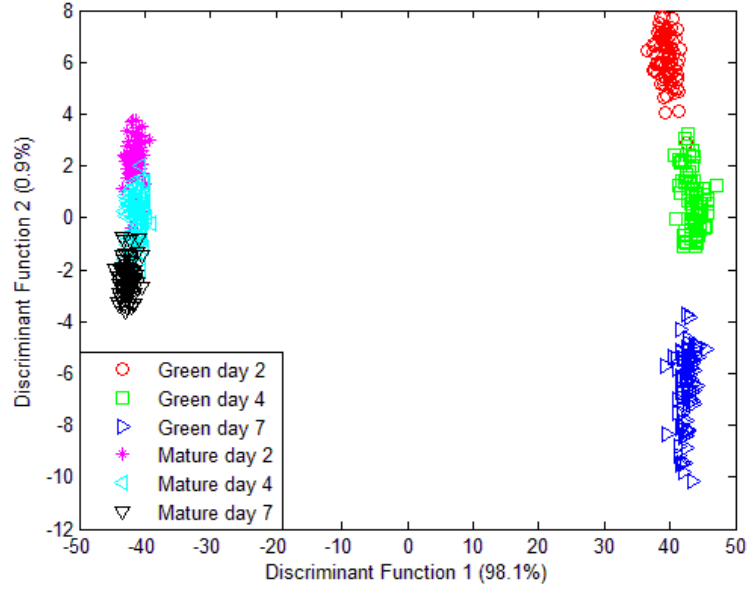
Figure 13. LDA plot using data fusion technique for three different maturity and ripeness level of Harumanis harvest at two different date (week 7 and week 8).